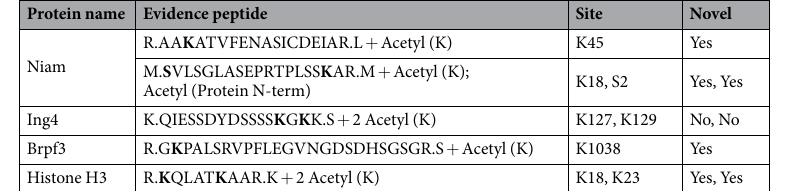
Table 1. Acetylated peptides from Myst2-associated proteins. Novel peptides are those not previously reported in the literature. Modified residues are shown in